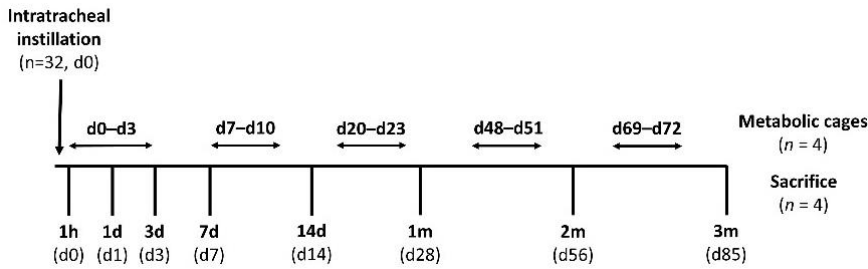
Figure 1. Experimental